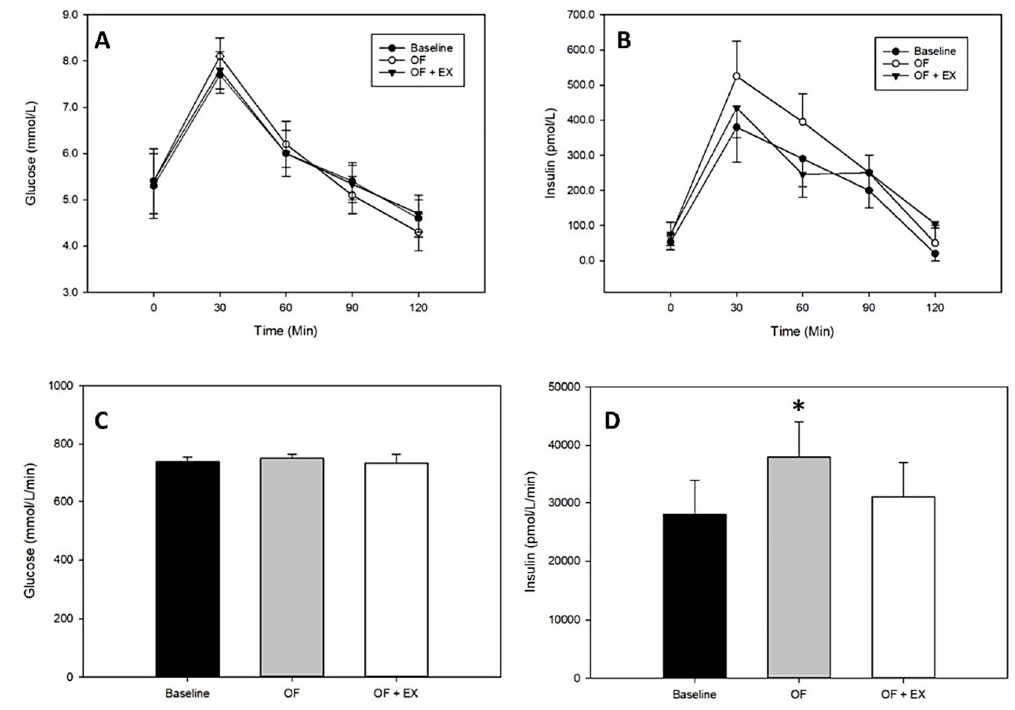
Figure 3. Top panels: glucose ( A ) and insulin ( B ) responses during a 2 h oral glucose tolerance test. Bottom panels: glucose ( C ) and insulin ( D ) areas under the curve. OF: overfeeding condition; OF + EX: overfeeding plus exercise condition. Values are mean ± SEM. * Significantly different from baseline, p < 0.05. Adapted from Hagobian and Braun, 2006 [41].